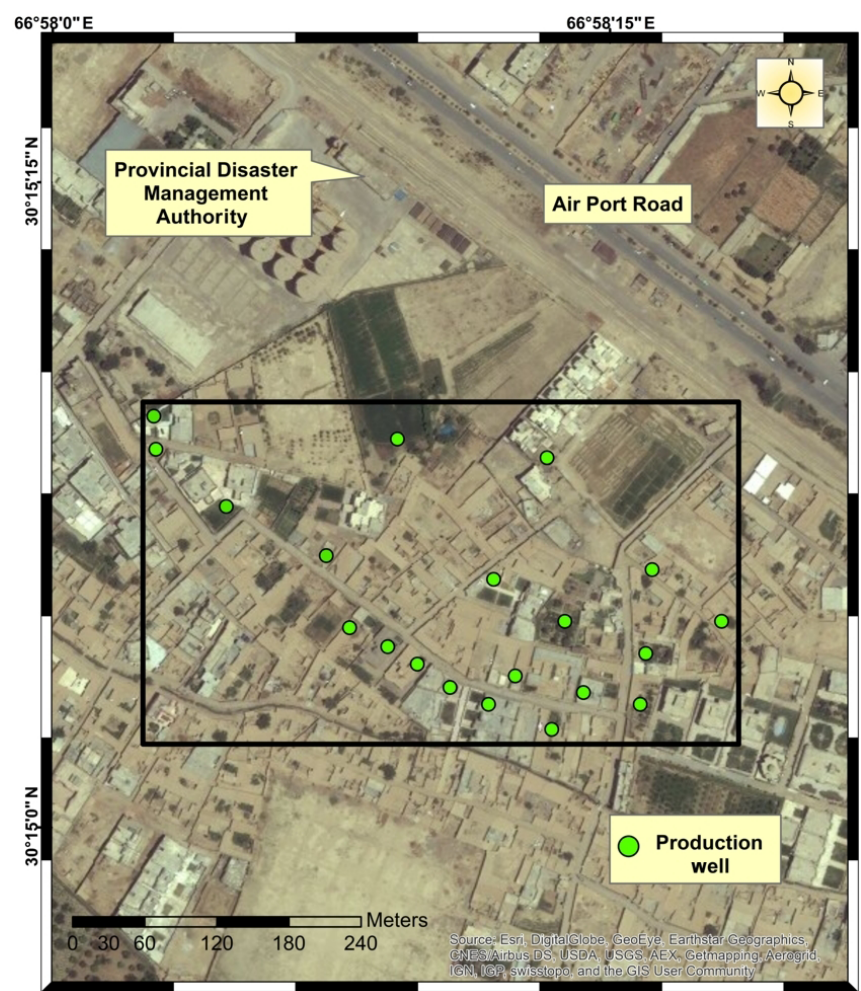
Figure 10. Location of drilled well sites at Sheikhmanda area. The green dots are the bore holes drilled in area of 1.3km 2 . Base map taken from ©Google